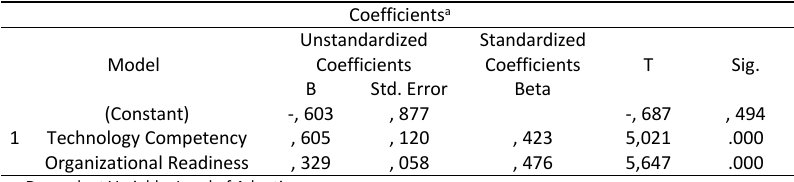
Table 5: Results of regression analysis and hypothesis testing Coefficients